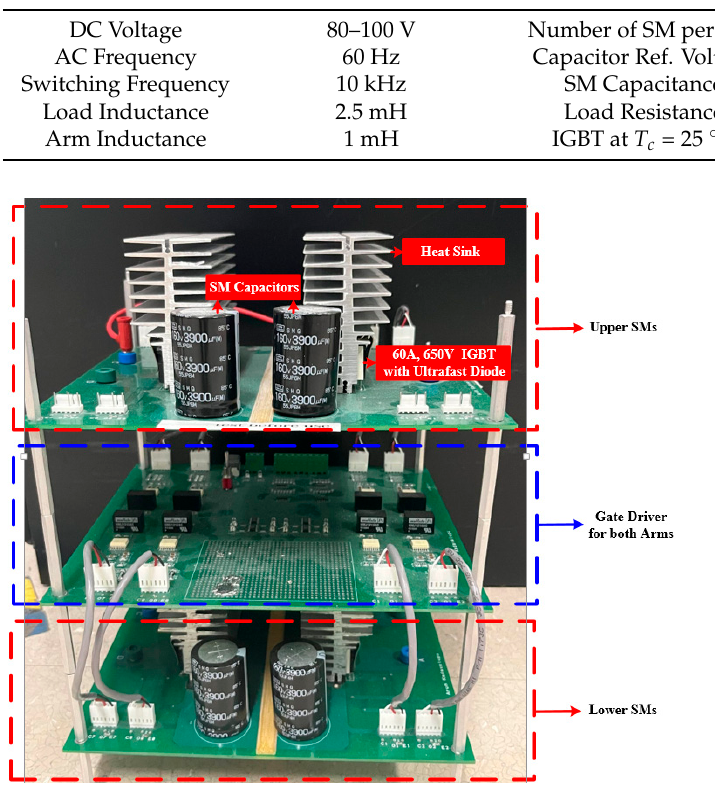
Table 1. System parameters.